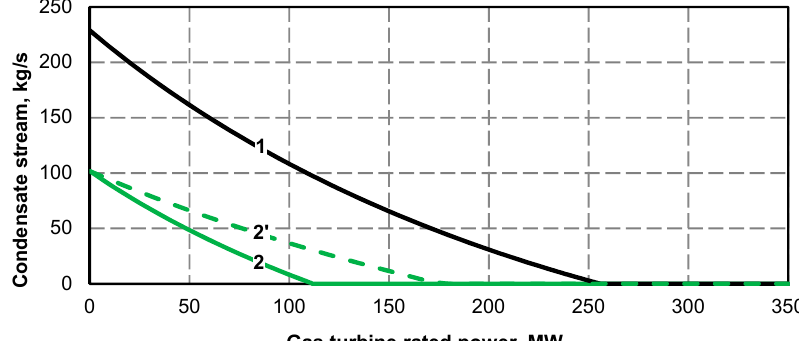
Figure 5. The stream of condensate fed from the KQ1 condenser to the XN1–XN4 low-pressure heat recovery exchangers as a function of gas turbine power: 1 — maximum fixed stream of 319.4 kg/s fresh steam fed to steam turbine; 2 — minimum steam boiler output of 133.3 kg/s and gas turbine operating with rated power, 2’ — minimum steam boiler output of 133.3 kg/s and gas turbine operating with 60% of its rated power.